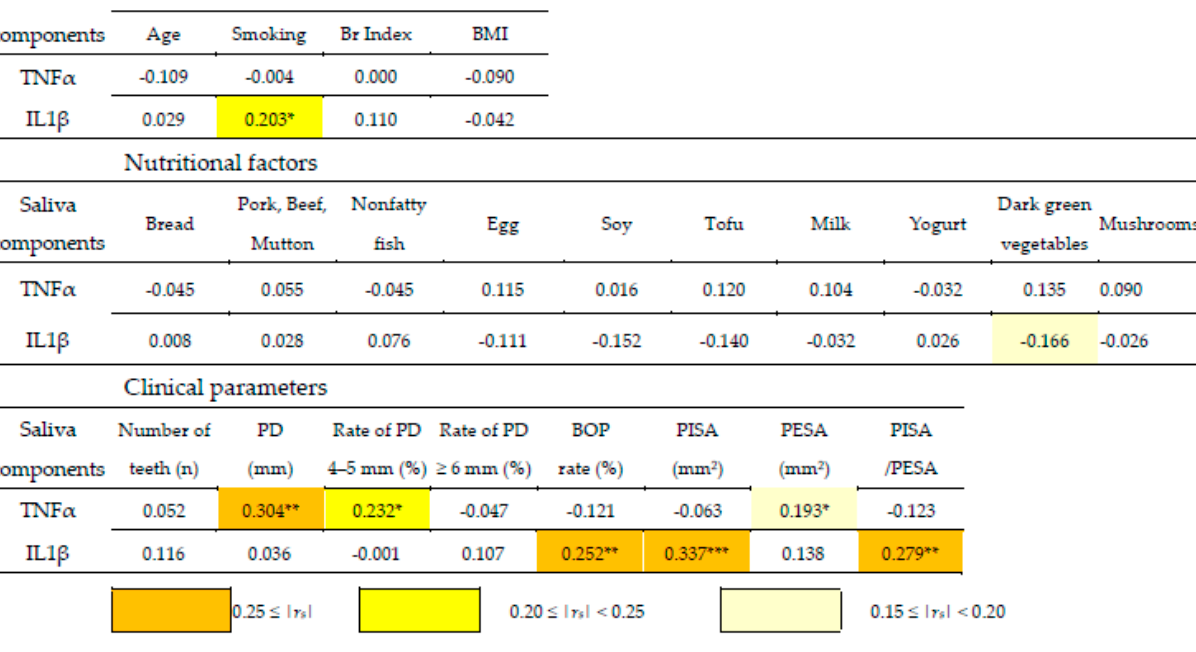
Figure 3. Correlation coefficients between inflammatory cytokines, environmental and nutritional factors, and clinical parameters. Spearman’s rank correlation coefficient ( r s ) between four environ- mental factors, ten nutritional factors, eight periodontal parameters, and two saliva inflammatory cytokines. Boxes in the matrix are colored based on the correlation coefficients as shown above. Student’s t-distribution was used to compare differences among correlation coefficients (* p < 0.05, ** p < 0.01). Abbreviations: TNF α , tumor necrosis factor α ; IL1 β , interleukin 1 β ; Br index,